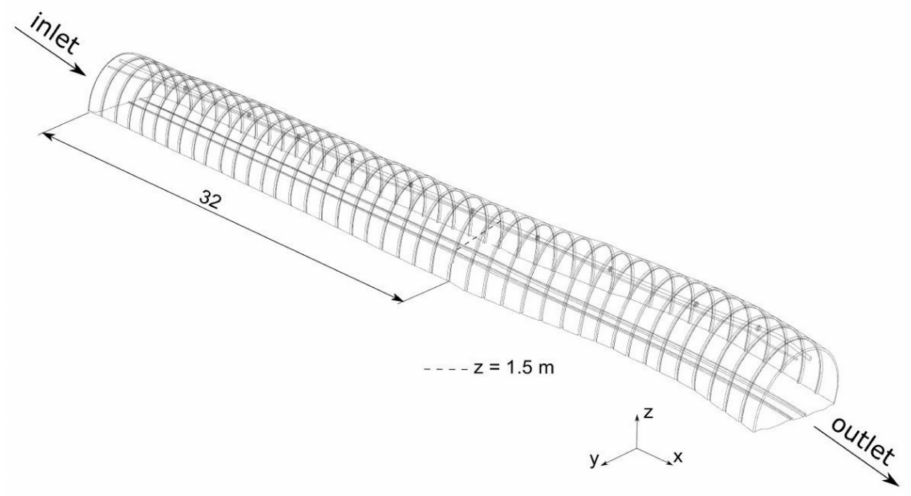
Figure 9. Location of measuring line.